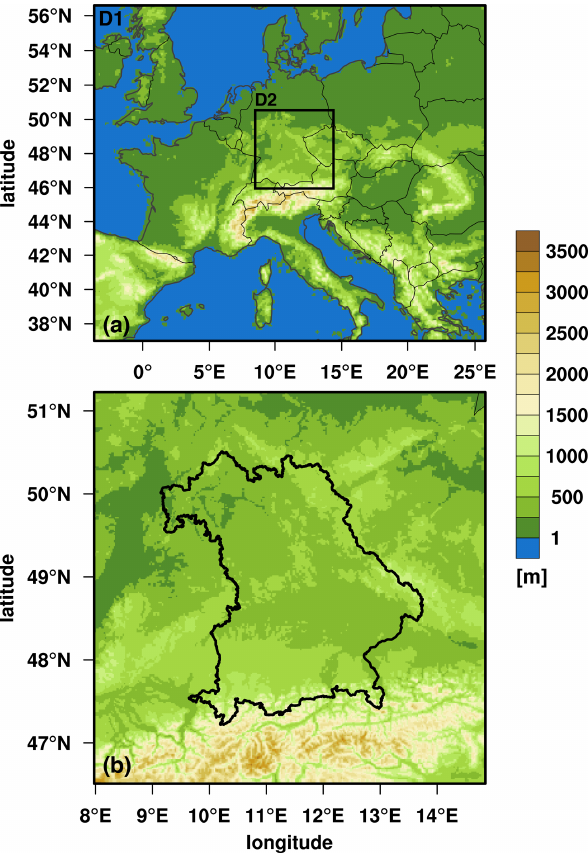
Figure 1. Extent and modelled topographic height in WRF D1 (a) and D2 (b) . The extent of D2 and of Bavaria are delineated in black in (a) and (b) ,